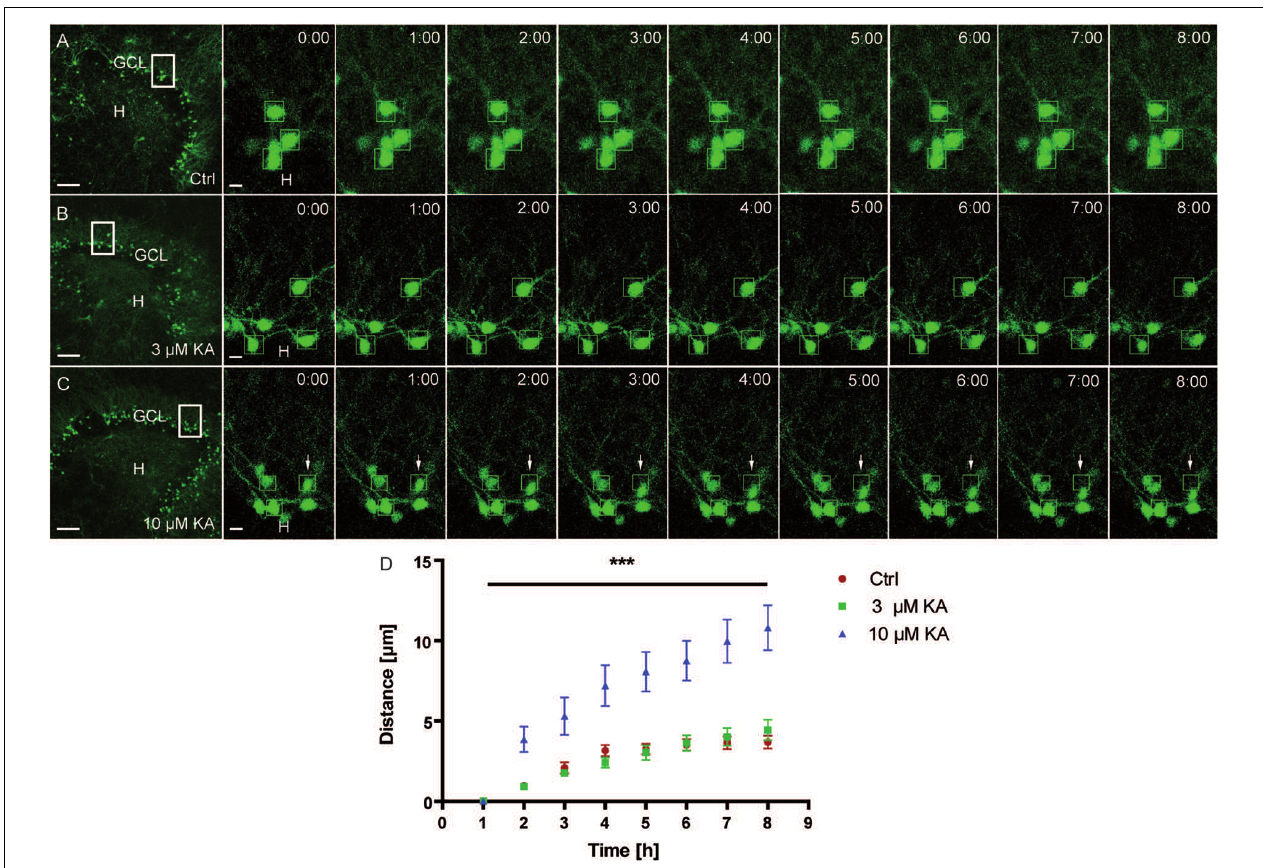
FIGURE 3 | Motility of granule cells depends on the KA concentration. Life cell imaging of individual eGFP-labeled granule cells was performed over a period of 8 h, and migration distances of randomly selected cells were assessed as described in Section “Materials and Methods.” Representative confocal micrographs of nine imaging time points are shown for each condition. Left panel: overview; white frame indicates the area shown at high magnification on the right. Tracked cells, are marked by green frames. (A) Control ( n = 4; 24 cells). Cells remain in place. (B) 3 µ M KA ( n = 4; 24 cells). Tracked cells behave similar to controls. (C) 10 µ M KA ( n = 3, 18 cells). Granule cells show increased motility (white arrows). (D) Statistical analysis of the motility of adult granule cells of control and KA-treated OHSC (3 µ M KA, 10 µ M). The migration behavior increases in a KA dose-dependent manner over the entire 8 h period. One-way ANOVA followed by Tukey’s test with ( ∗∗∗ P < 0.001). GCL, granule cell layer; H, hilus. Scale bars: 80 µ m for overview; 5 µ m for high